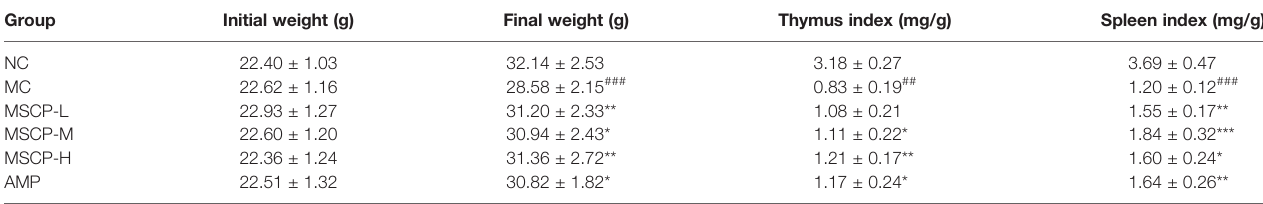
TABLE 2 | Effects of MSCP on body weight and immune organ indices in immunosuppressive mice. Group